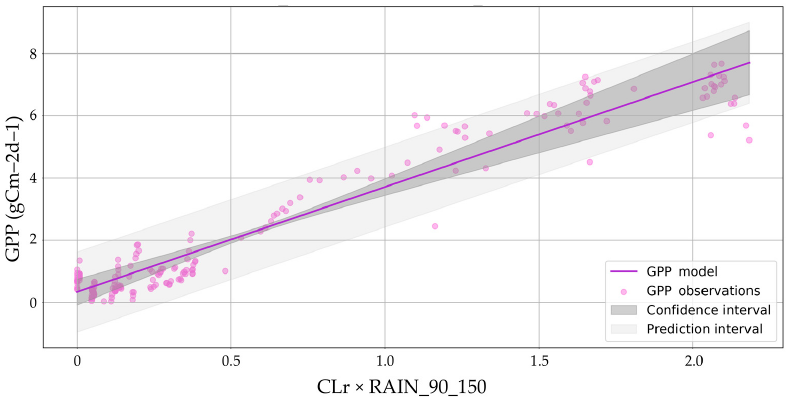
Figure 6. Scatter plot and corresponding regression line and 95% confidence interval for the relationship between the GPP calculated as the product between the Red-edge index (CLr) and the rainfall data calculated with a rolling average of 90 days and delay of five months (RAIN_90_150) and the ground measurements of GPP.